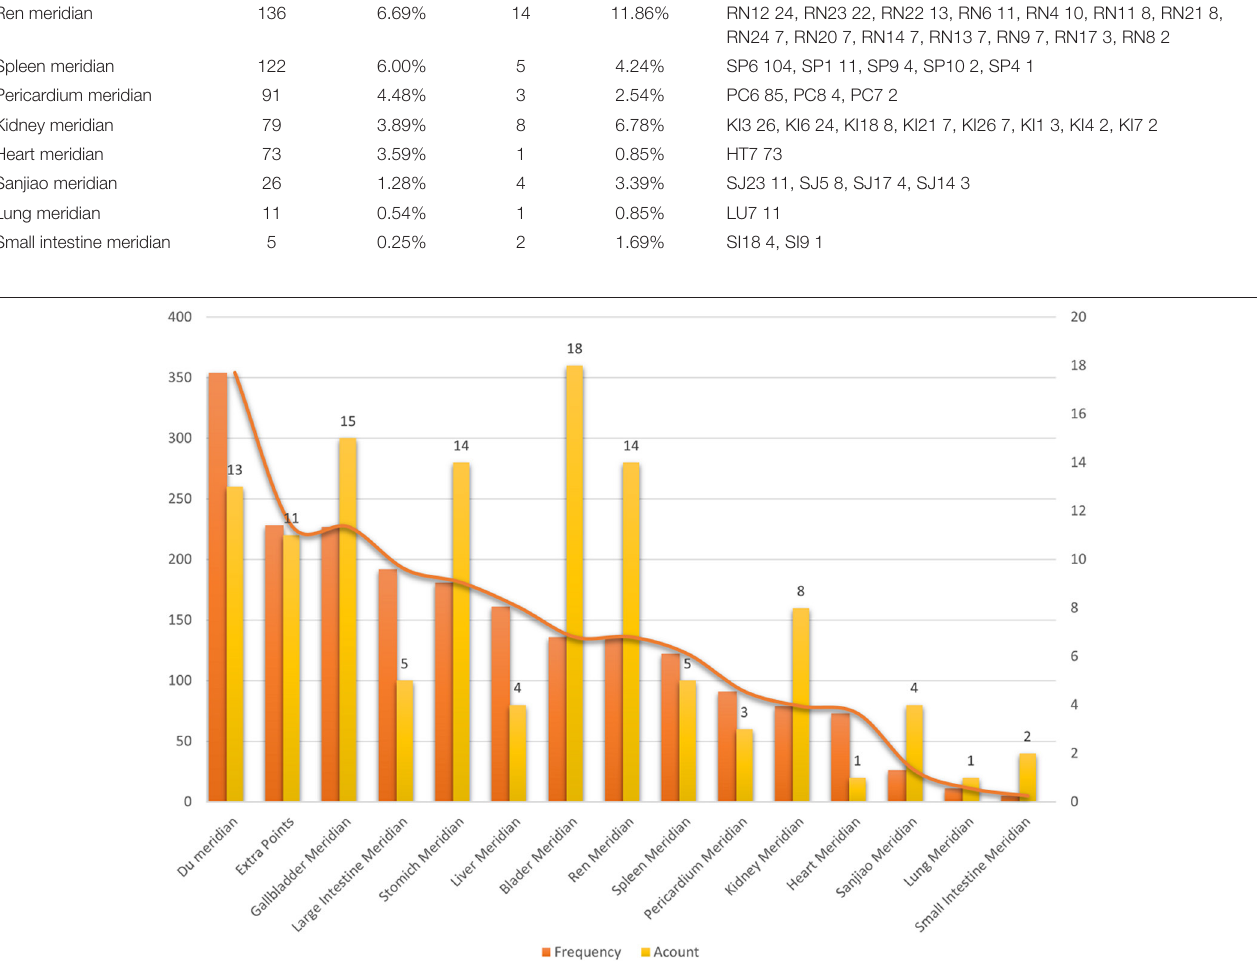
FIGURE 4 | Frequency of meridian application for TD